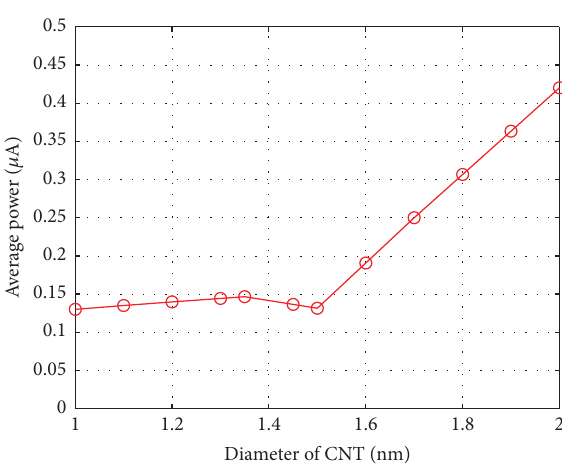
Figure 3: Effect of CNT diameter on the delay.